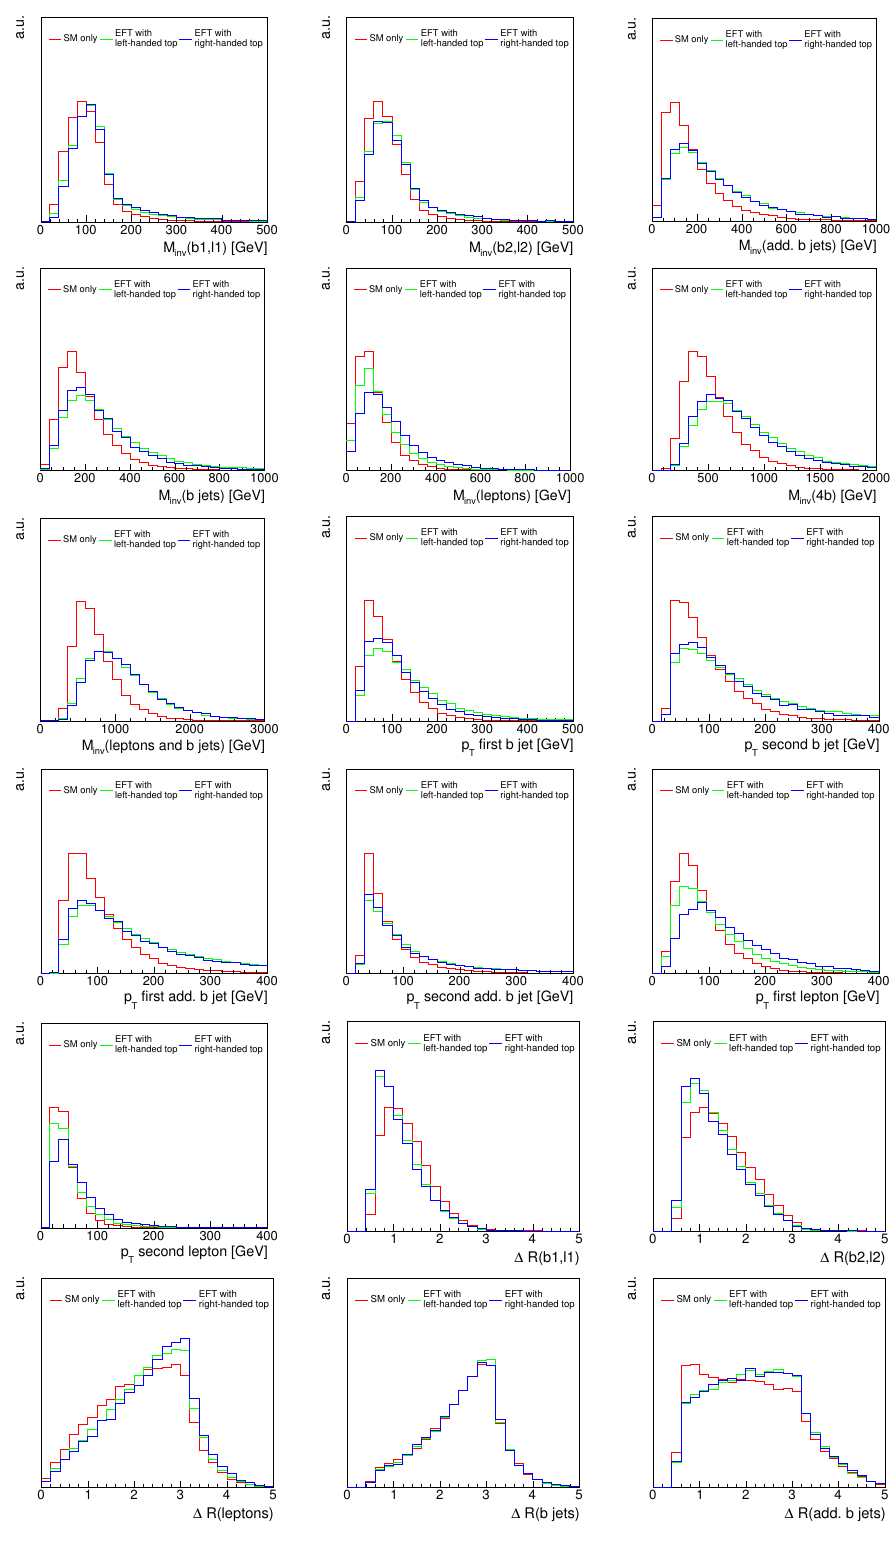
Figure 18 . Normalized distributions of the neural network input variables for SM events (red), left-handed top operators (green) and right-handed top operators